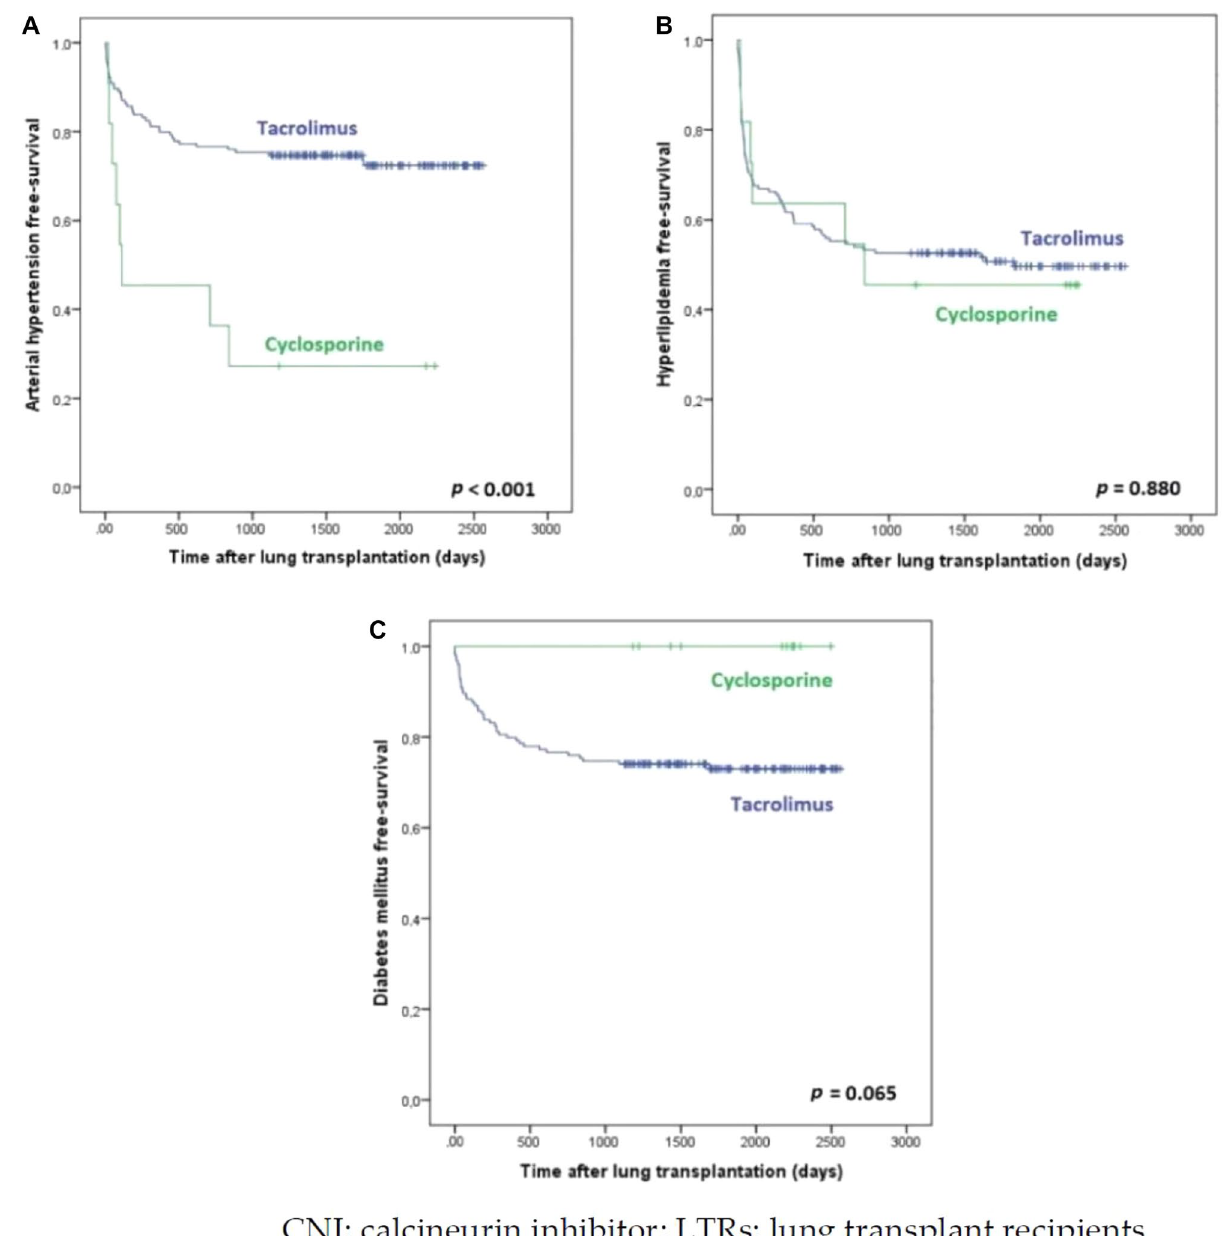
Figure 1. Development of cardiovascular risk factors according to the CNI drug prescribed in our cohort of LTRs in the post-transplantation period: ( A ) Development of arterial hypertension; ( B ) development of hyperlipidemia; ( C ) development of diabetes